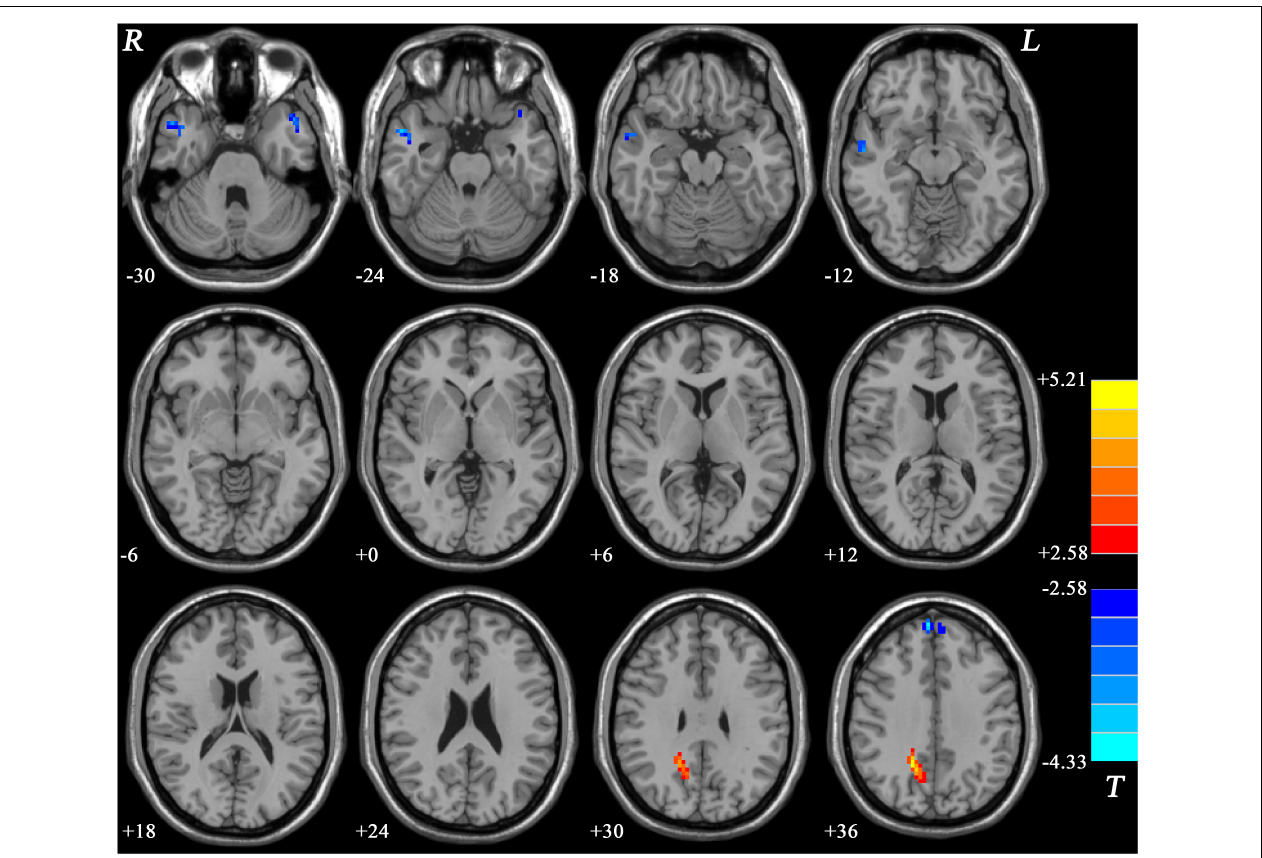
FIGURE 3 | Statistical map depicts higher and lower NH of MDD patients with GI symptoms compared with healthy controls. The threshold was set at p < 0.05. Blue denotes lower NH, and red denotes higher NH. Color bar indicates T values from two-sample t -test. NH, network homogeneity; GI, gastrointestinal symptoms.